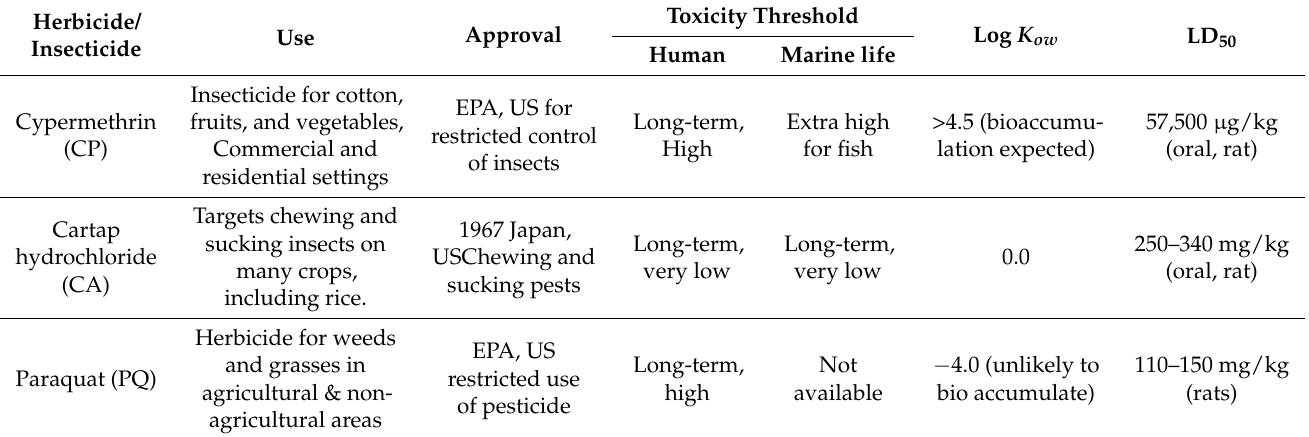
Figure 1. The chemical structures of the tested pesticides — Cypermethrin (CP), Paraquat (PQ), and Cartap hydrochloride (CA). Table 1. The various properties and harmful effects of the pesticides utilized in this study .